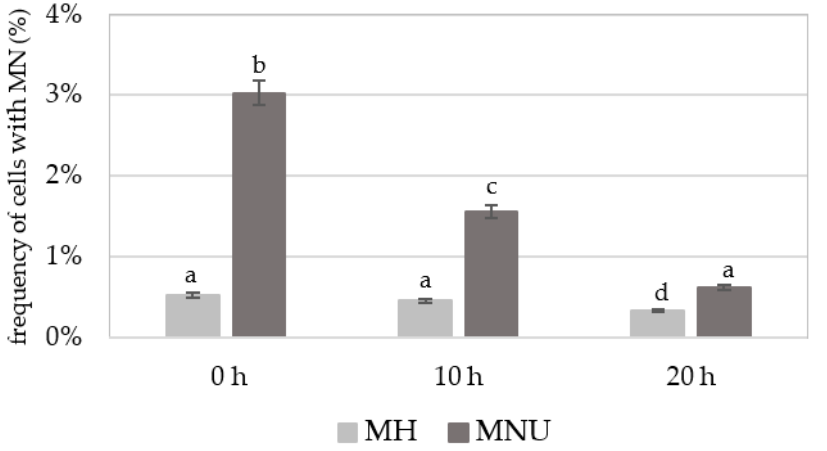
Figure 1. Frequency of B. distachyon cells with micronuclei (MN) after MH and MNU treatment. No micronuclei were observed in the control cells. ANOVA followed by Tukey HSD test, p < 0.05; mean ± SD, statistically significant differences are indicated by different letters.